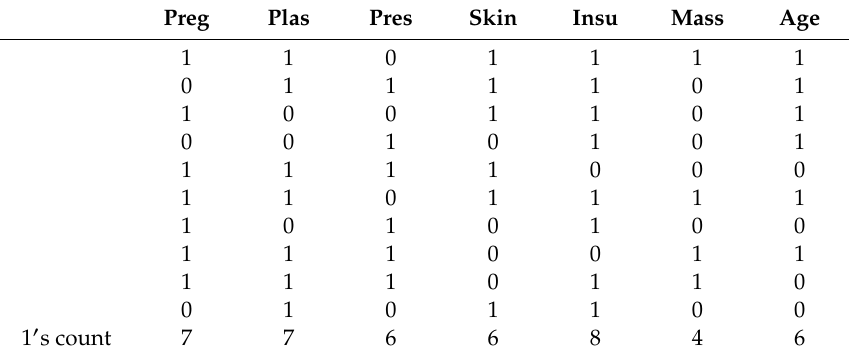
Table 19. Final Optimal and Enhanced Attribute set after k generations.